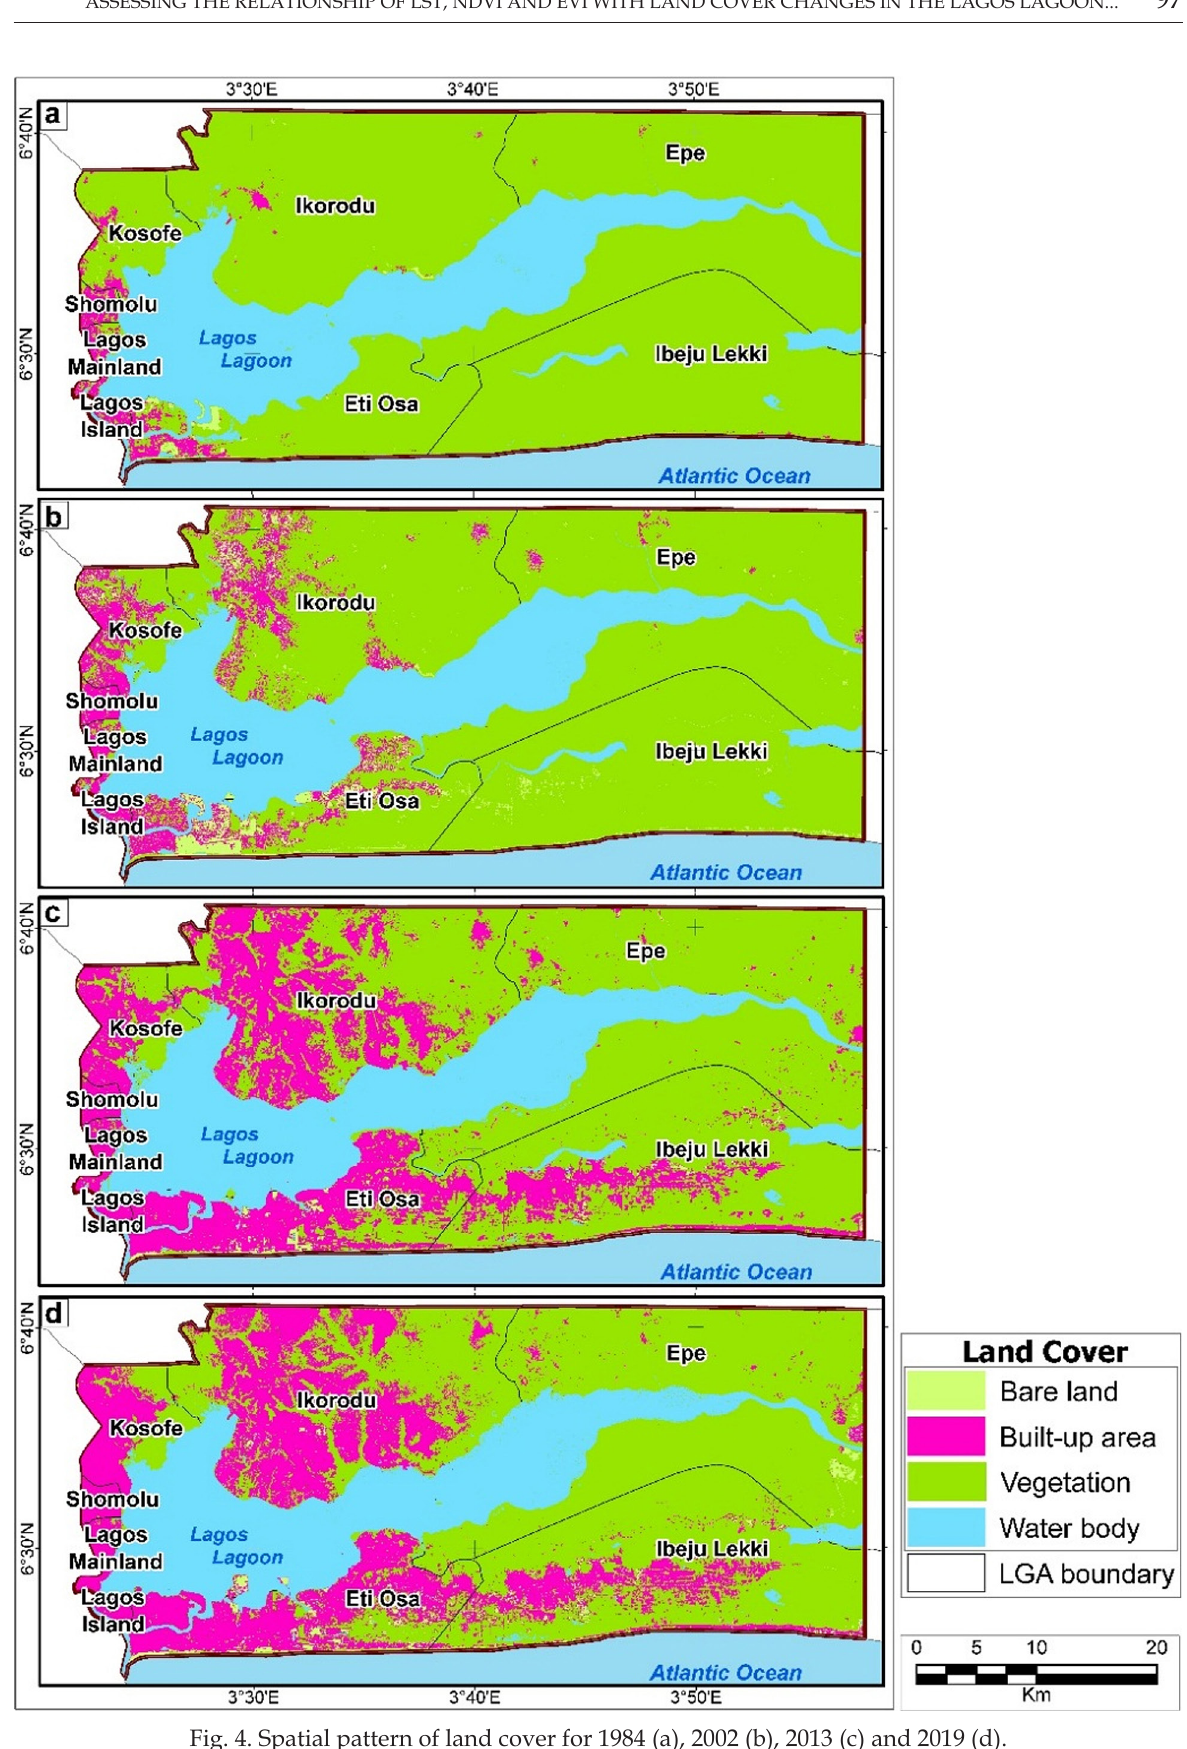
Fig. 4. Spatial pattern of land cover for 1984 (a), 2002 (b), 2013 (c) and 2019